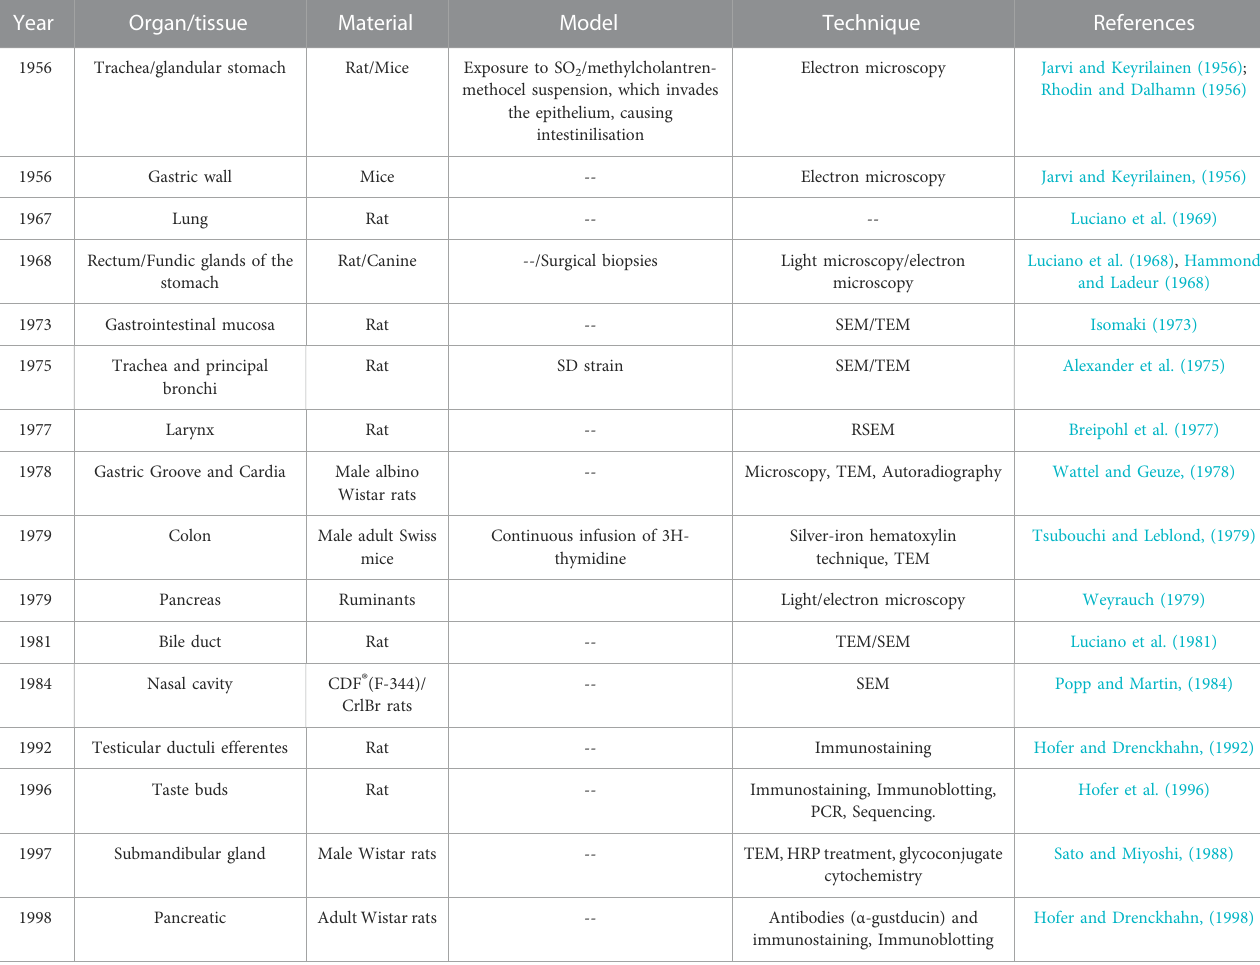
TABLE 1 Milestones of TC identi fi ed in different cells and